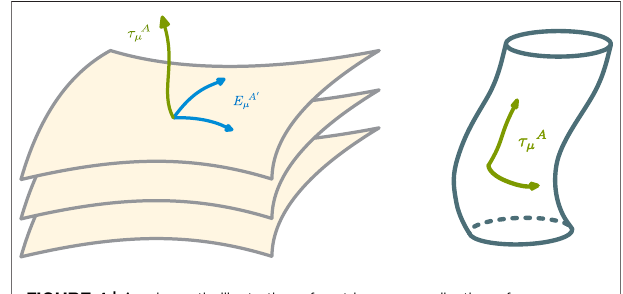
FIGURE 4 | A schematic illustration of a stringy generalization of Newton – Cartan geometry. The green arrows represent the two longitudinal directions along the worldsheet, whose geometry is encoded in the vielbein fi elds τ μ A . Each horizontal slice represents the ( d − 2)-dimensional transverse directions, parametrized by the vielbein fi elds E μ A ′